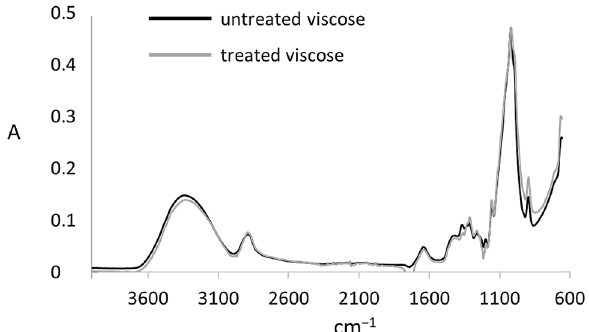
Figure 10. IR spectra of untreated (black line) and pMDI-hardener treated and NMP purified (grey line) yarns.